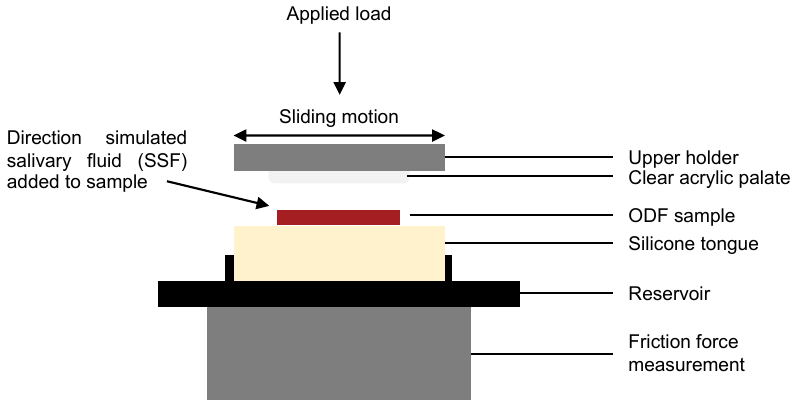
4 of 16 Table 1. ODF polymer formulation solution composition and optimised 3D printing parameters. ODF ID